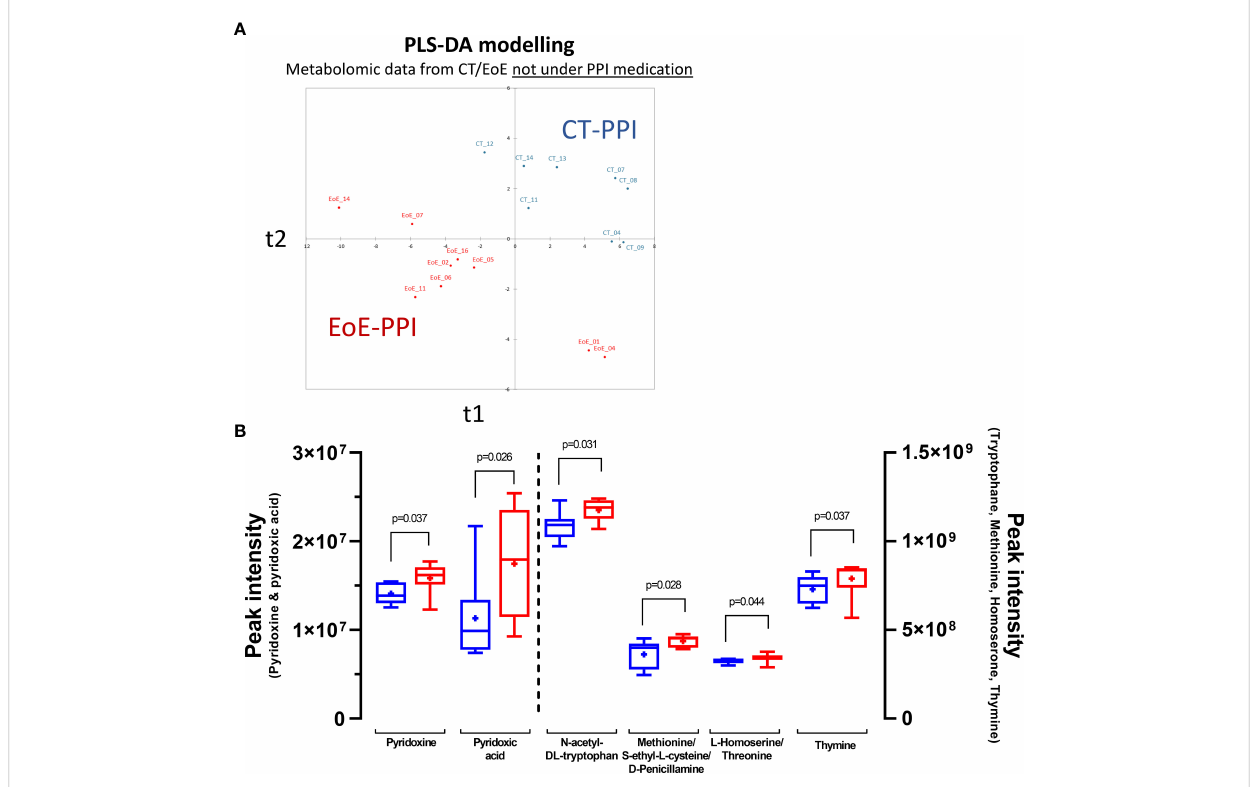
FIGURE 5 Discrimination of EoE versus control based on plasma metabolome: (A) Graph of individuals after PLS-DA modelling of metabolomics data from EoE patients not under medication (EoE-PPI: n=9; red) versus that from CT not under PPI medication (CT-PPI: n=8; blue). Model characteristics: R²Ycum=0.905, R²Xcum =0.333, AUC=1, 100% sensitivity and speci fi city. (B) Discriminant metabolites showing signi fi cant differences when comparing EoE patients (red) to controls